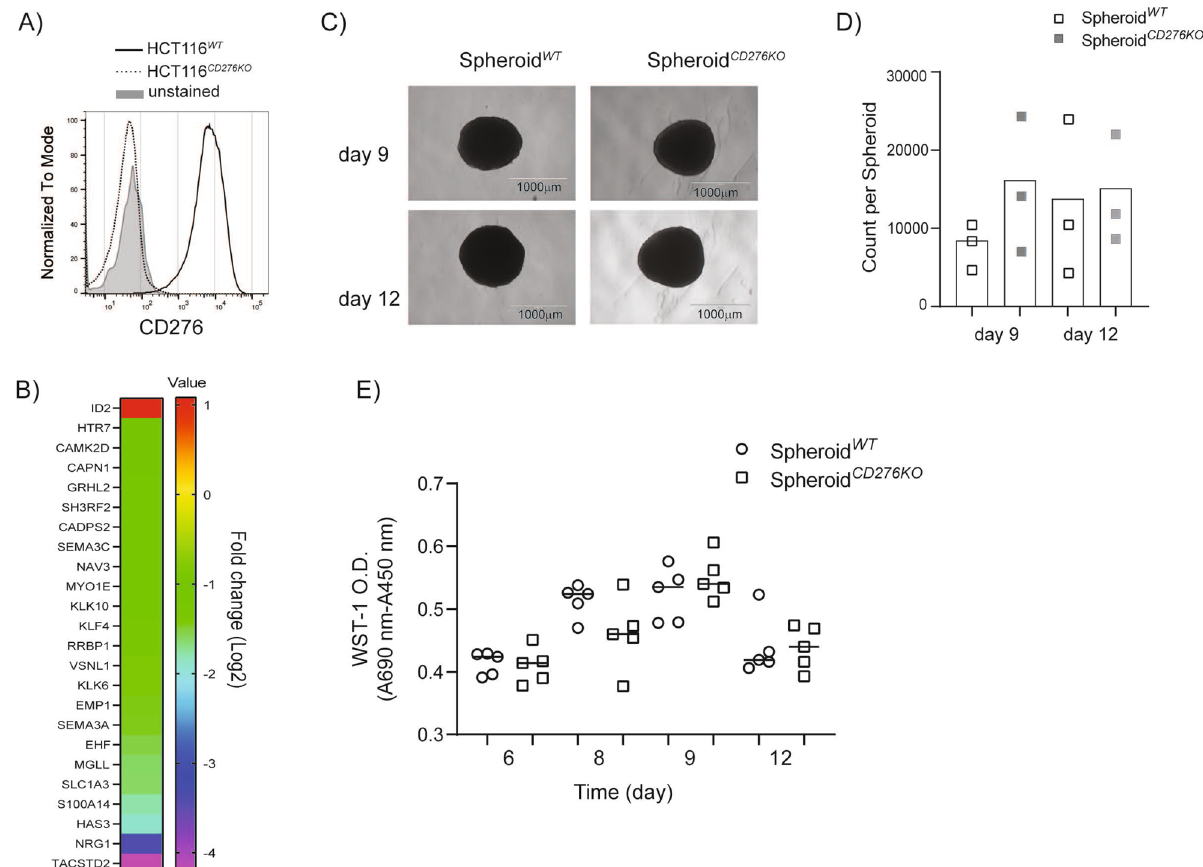
Figure 1. HCT116 CD276KO cells form tumor spheroids similar to HCT116 WT cells. ( A ) CD276 expression on HCT116 WT and HCT116 CD276KO cells was analyzed by flow cytometry after Crispr-Cas9 gene editing. ( B) The heat-map shows the differentially regulated genes related to cell adhesion and migration in HCT116 CD276KO cells compared to HCT116 WT cells according to global transcriptome analysis. The bar shows the fold change (log2) of the ratio from tpm values (transcripts per kilobase million) of genes in HCT116 CD276KO cells to genes in HCT116 CD276WT cells. ( C) Tumor spheroids formed from HCT116 WT and HCT116 CD276KO cells were monitored up to 12 days for shape. Representative microscope images are from 9-day and 12-day culture. ( D) Quantification of viable tumor cells per spheroid was assessed by flow cytometry. 5–10 spheroids were pooled into a single sample for each group and before dissociation a defined number of negative compensation flow cytometry beads were added. Ratio of recorded bead count to the initial bead amount was used to back calculate viable tumor cells. The graph summarizes data (Mean + SD) from three independent experiments. ( E) WST-1 viability assay treatment of spheroids over time. Each dot is one